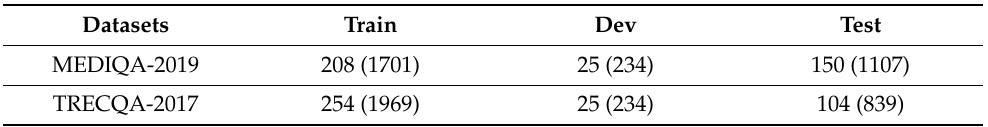
Table 2. Basics about MEDIQA-2019 and TRECQA-2017 [41]: number of questions (outside parenthe- sis) and number of associated answers (inside parenthesis).